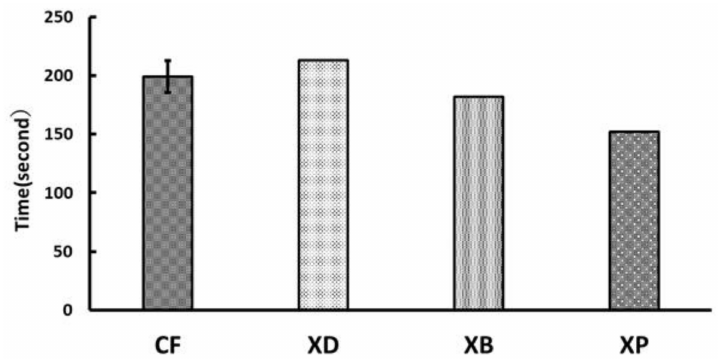
Figure 4. Time when the polymerization contraction reached a constant speed of short fiber reinforced composites (0.1 µ m/s or less) (TPS) (I: 95% confidence interval).